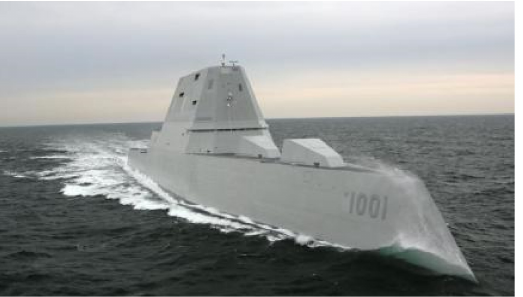
Figure 4. Specific ship target appearance diagram (real-scene